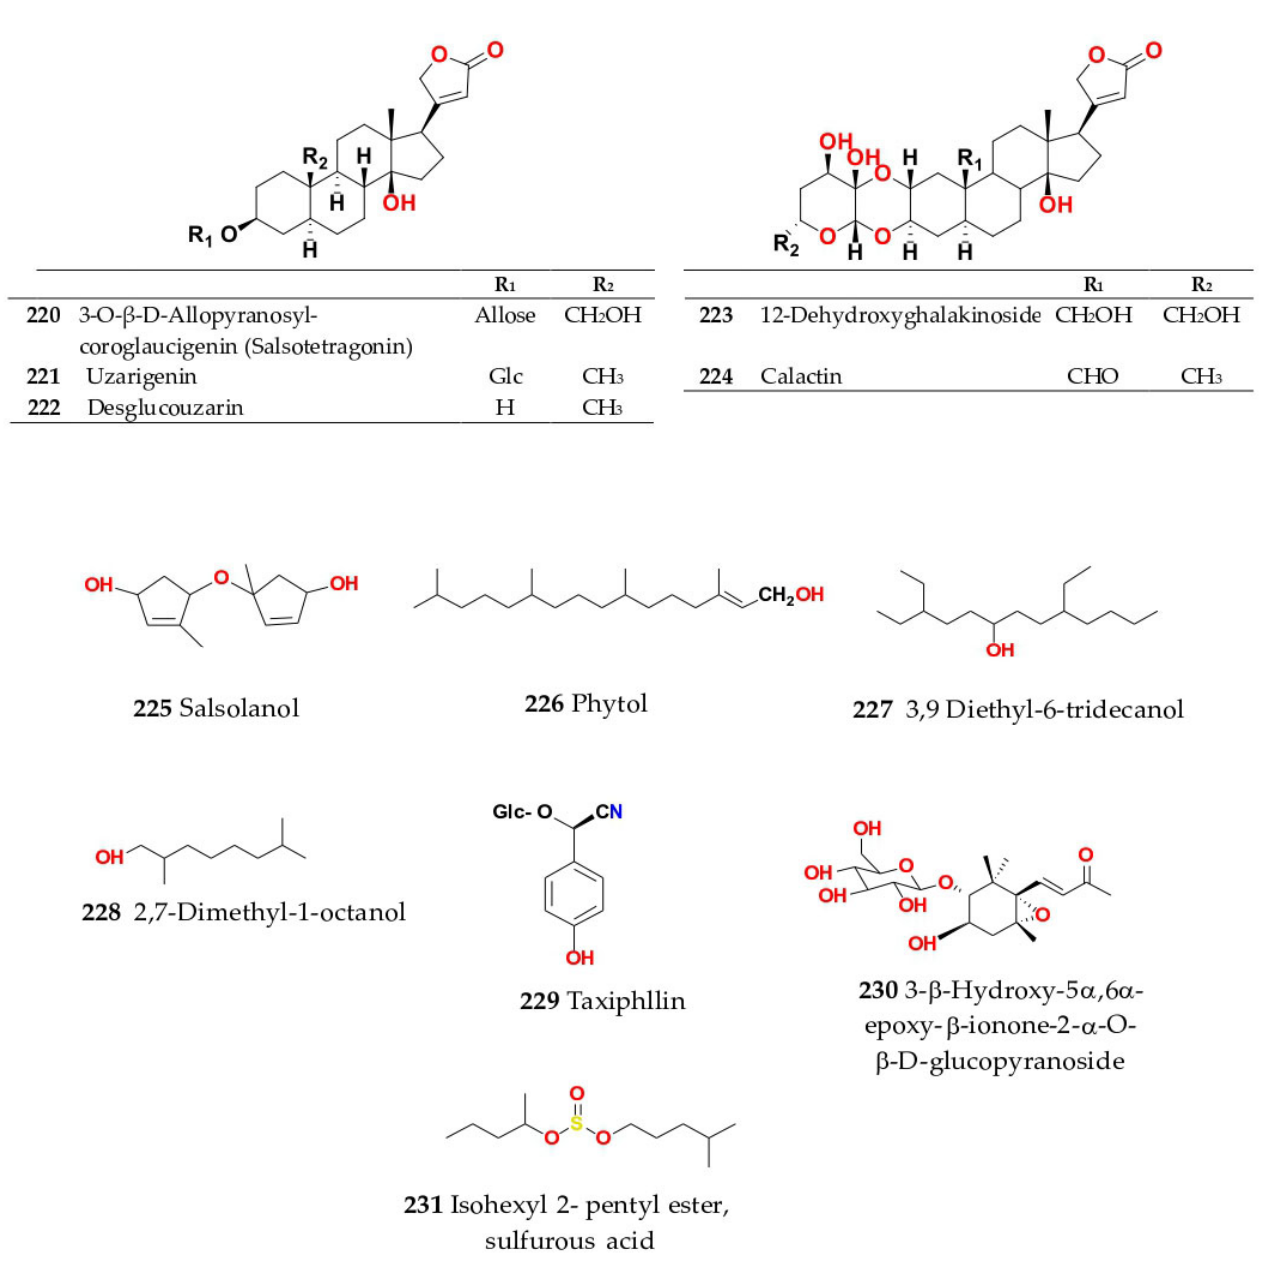
Figure 17. Chemical structure of cardiac glycoside-, alcohol-, cyanogenic-, isoprenoid-, and Sulphur-containing compounds isolated from genus Salsola.